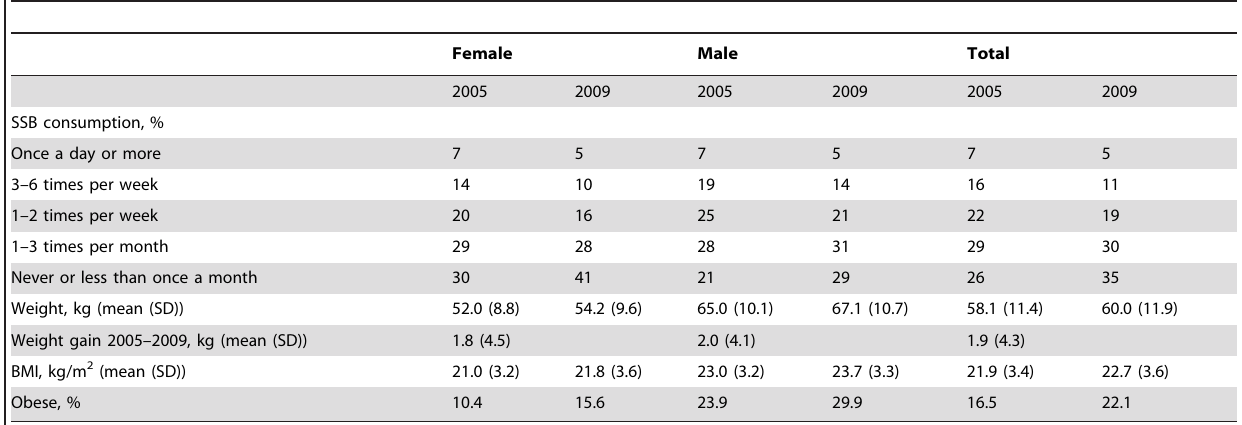
Table 1. SSB consumption and body size measures in 2005 and 2009 (n=